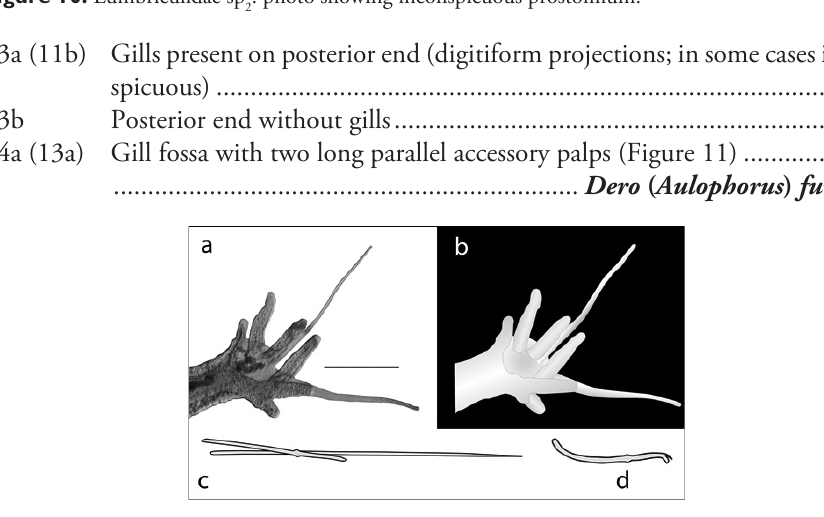
Figure 11. Dero ( Aulophorus ) furcatus : A photo of posterior end showing digitiform gills and elongate palps (scale 250 µm) B drawing of A C drawing of typical chaetae bundle D drawing of typical ventral